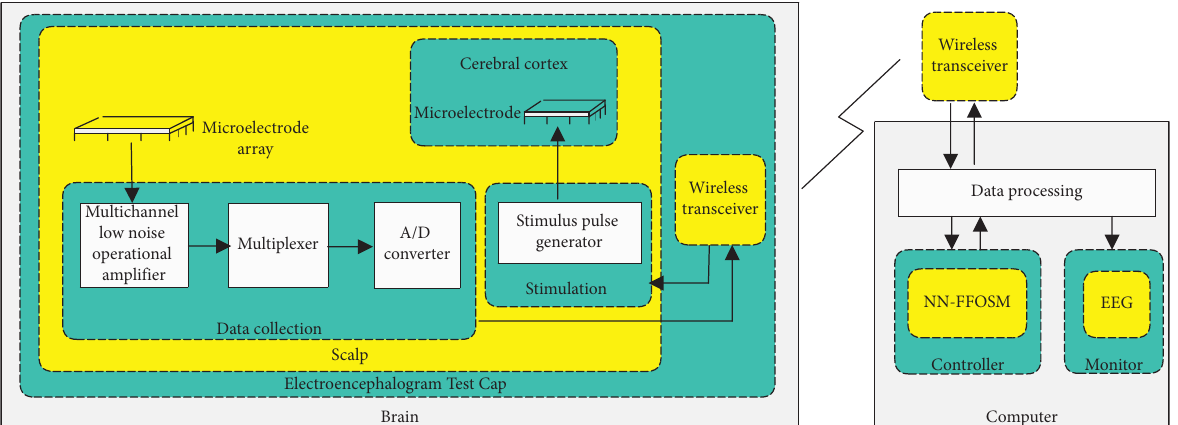
Figure 2: Closed-loop brain stimulation control system scheme based on BMI for epilepsy.